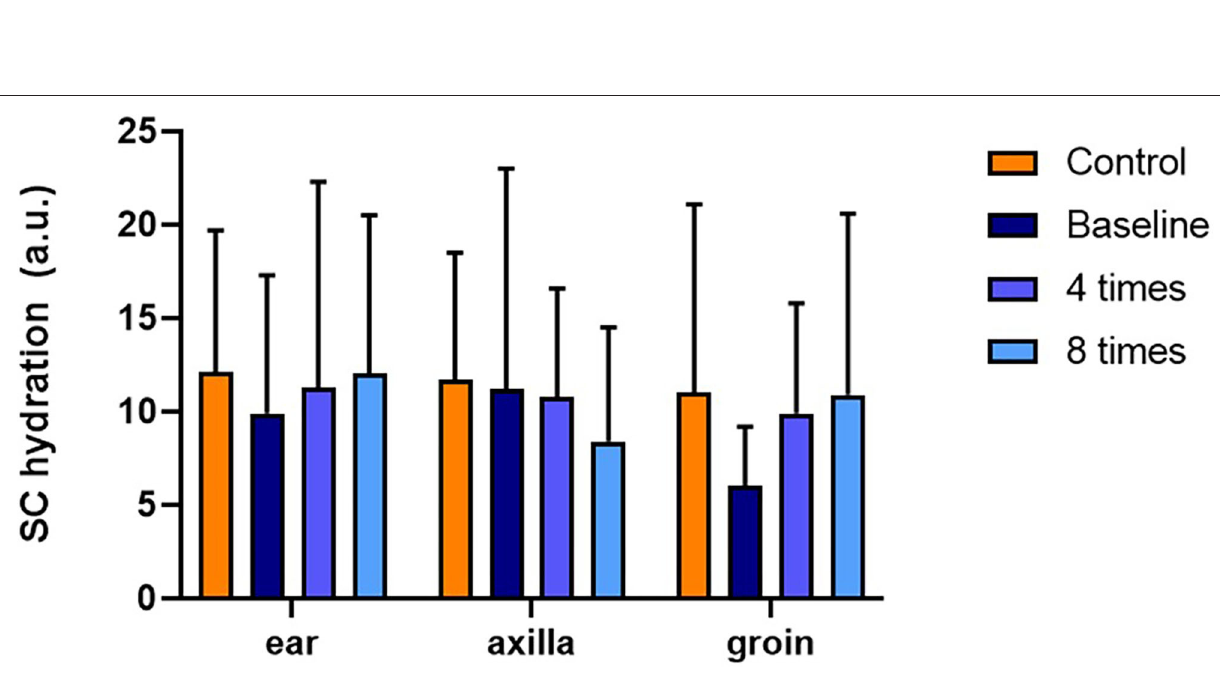
Frontiers in Veterinary Science | www.frontiersin.org